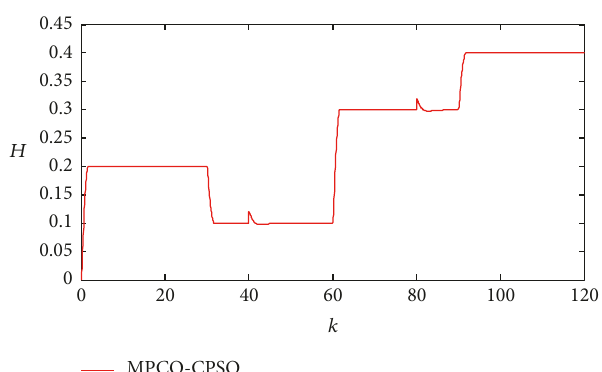
Figure 5: Evolution of liquid level 𝐻 in the presence of